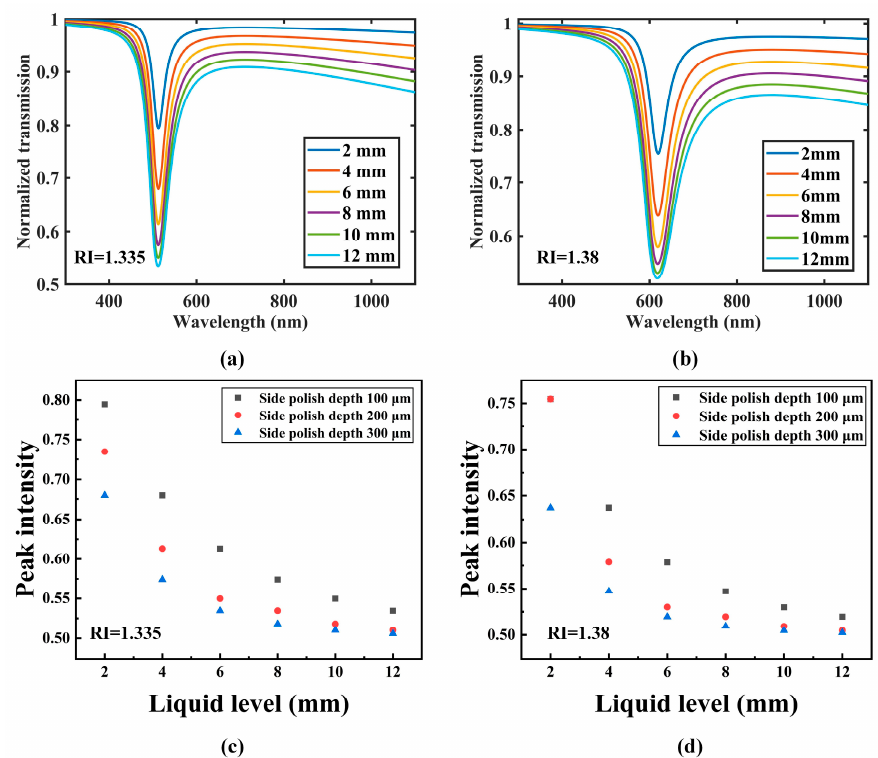
Figure 5. Simulation results of the liquid level sensing: ( a ) The solution with RI of 1.335; ( b ) The solution with RI of 1.38; The simulation results of liquid level sensing performance of probes with different polished depths in the liquid with RIs of 1.335 ( c ) and 1.38 ( d ).